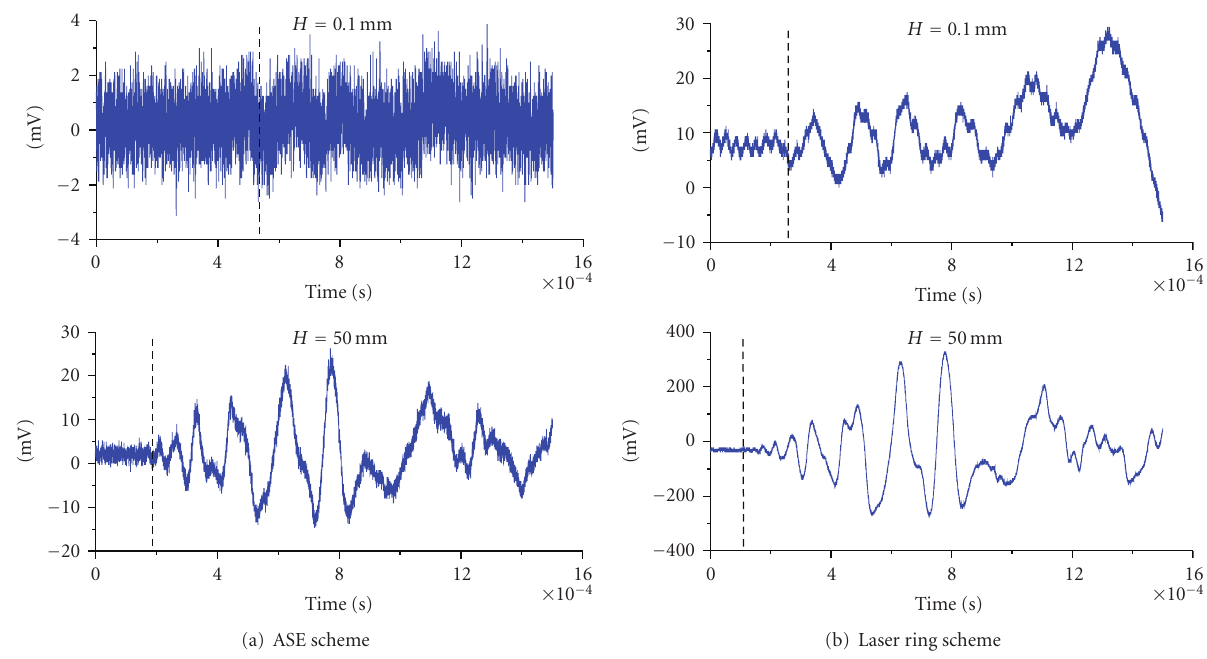
Figure 5: Impact signals obtained on the aluminum plate using (a) the ASE light source and (b) the laser ring scheme. (Dotted lines indicate the signal first arrival time).